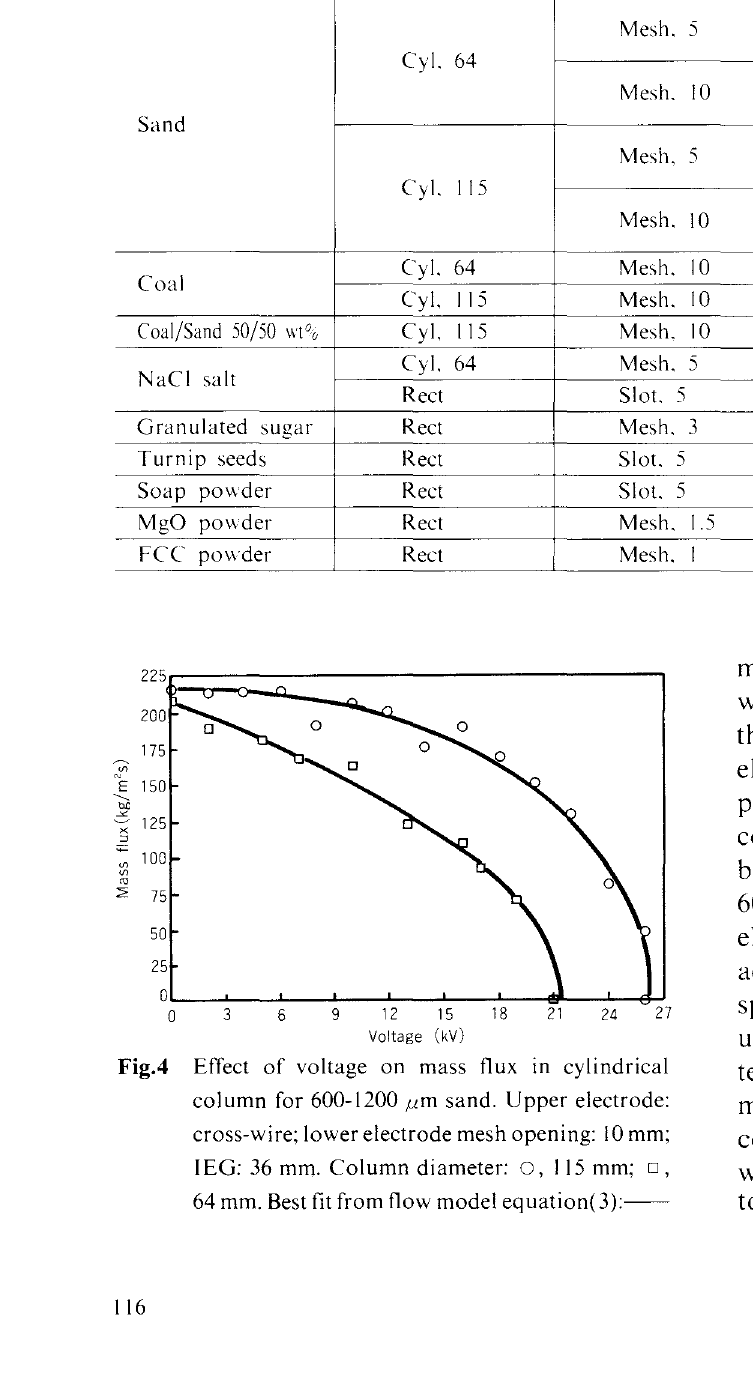
Voltage (kV) Fig.4 Effect of voltage on mass flux in cylindrical column for 600-1200 ,urn sand. Upper electrode: cross-wire; lower electrode mesh opening: 10 mm; lEG: 36 mm. Column diameter: o, 115 mm; o, 64 mm. Best fit from flow model